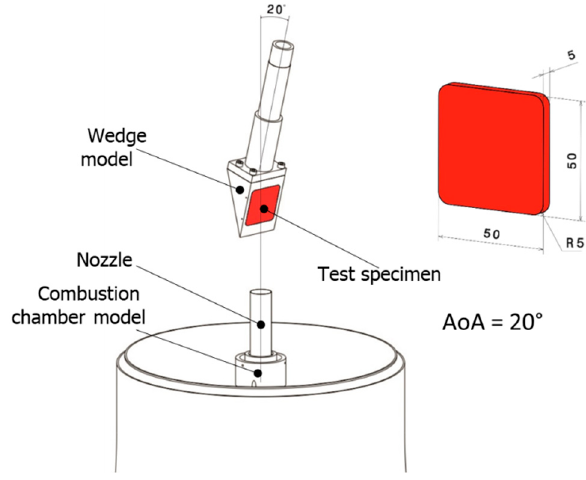
Figure 1. VMK experimental test facility arrangement.